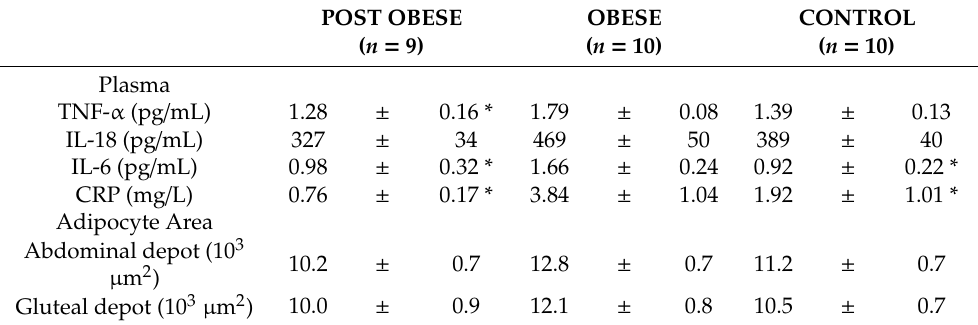
Table 2. Systemic low-grade inflammation and adipocyte area in Post obese, Obese, and Control male subjects. POST